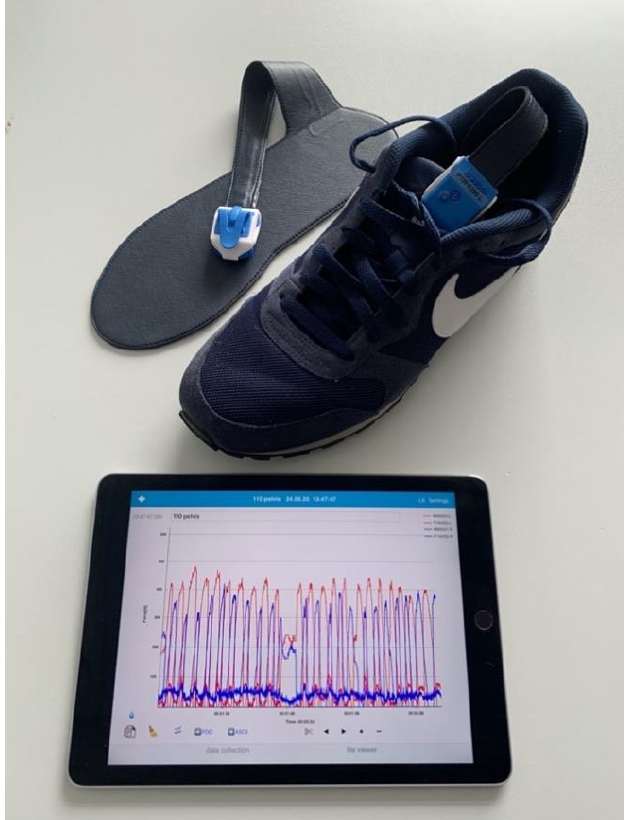
Figure 3. Setup of the Loadsol ® insole sensor device. Figure 1. Setup of the Loadsol ® insole sensor